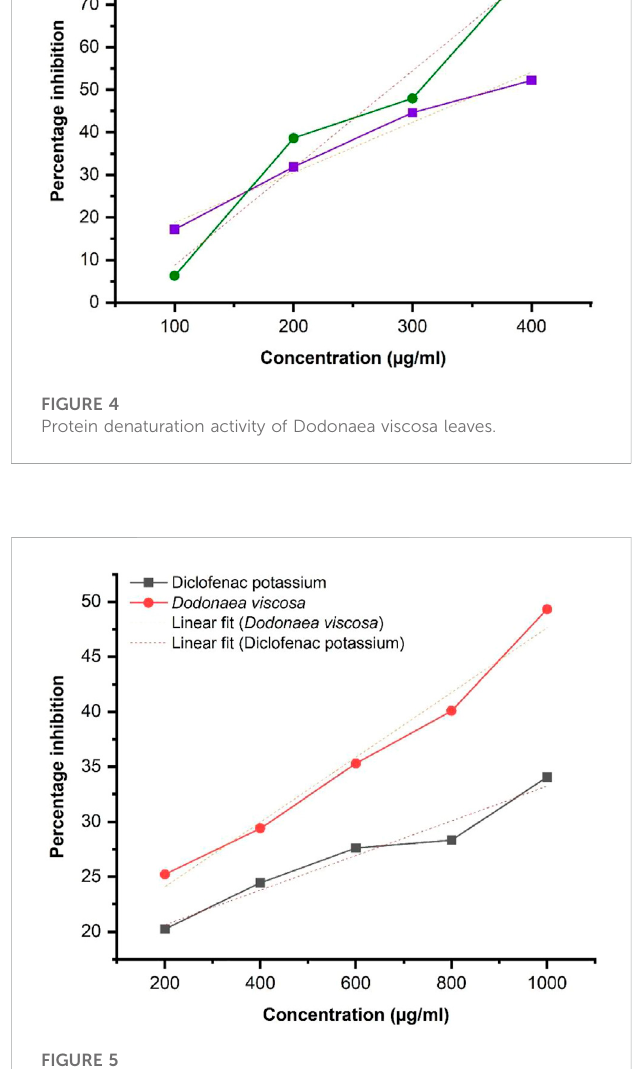
FIGURE 5 Percent inhibition of HRBC membrane stabilization of ethanolic D. viscosa extract.